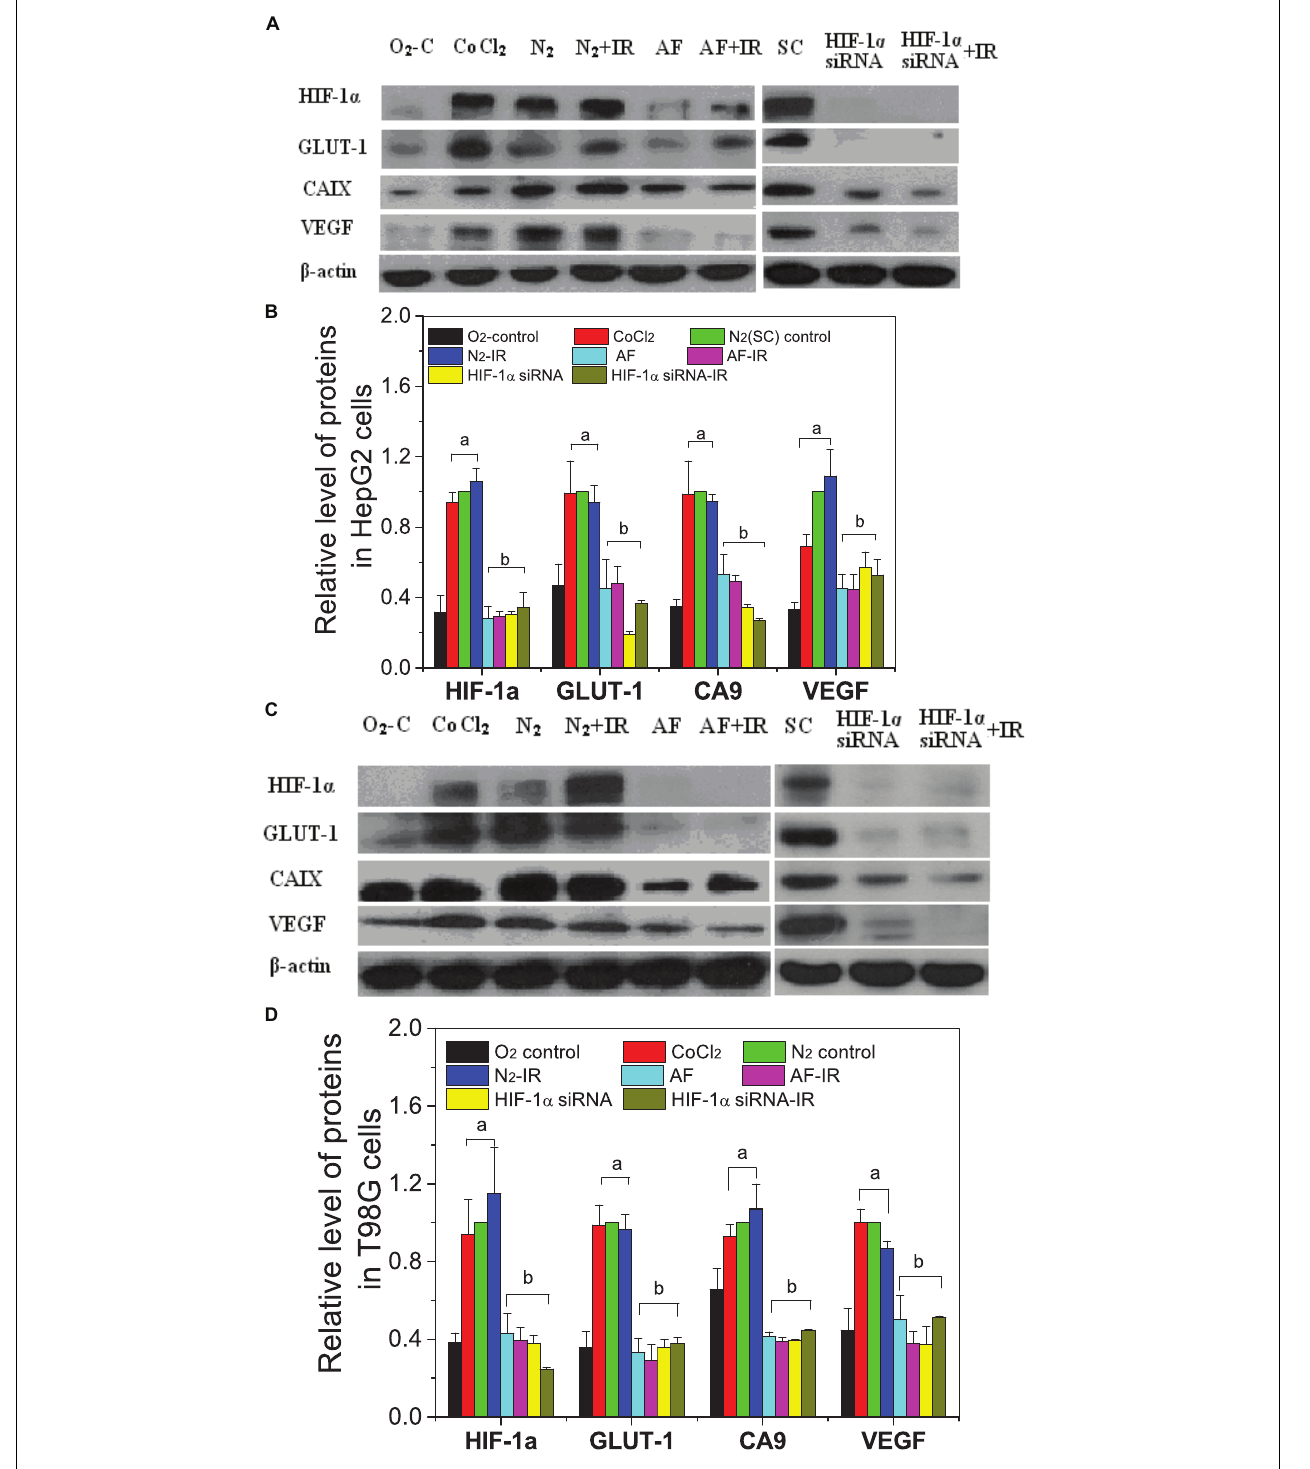
FIGURE 7 | Expressions of HIF-1 α and downstream proteins in hypoxic-irradiated cells pretreated with HIF-1 α inhibitor treatment. The HepG2 cells (A,C) and T98G cells (B,D) were pretreated with or without 100 µ M CoCl 2 , 5 µ M 7-aminoflavone for 4 h, and HIF-1 α siRNA for 24 h before irradiation under normoxic or hypoxic conditions, then nuclear or whole proteins were collected and analyzed at 4 h post 5 Gy X-irradiation. The HIF-1 α signal and its downstream proteins were compared with the corresponding β -actin and then normalized to that protein under hypoxia. a, p < 0.05 compared with the normoxic control; b, p < 0.05 compared with the hypoxic control without